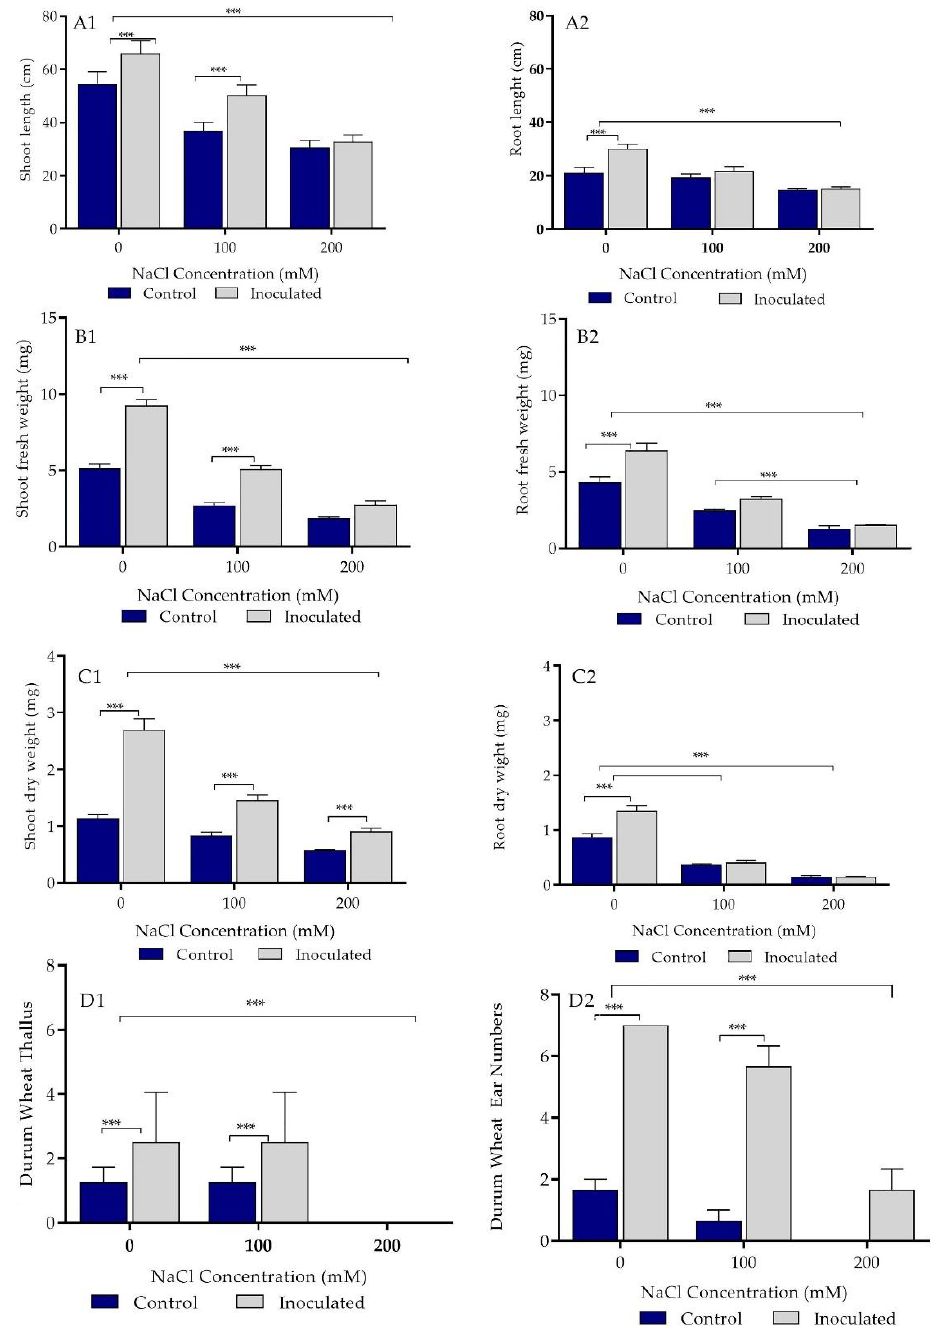
Figure 5. E ff ect of PGPR P. agglomerans strain Pa inoculation on growth parameters of durum wheat cv Waha grown in saline and non-saline settings in soil pots. ( A1 , A2 ) E ff ect of bacterial inoculation (strain Pa) on shoot and root length (cm) in the presence of three concentrations (0, 100, and 200 mM) of NaCl. ( B1 , B2 ) E ff ect of bacterial inoculation (strain Pa) on shoot and root fresh weight (mg) of Triticum durum L. cv Waha in the presence of three concentrations (0, 100, and 200 mM) of NaCl. ( C1 , C2 ) E ff ect of bacterial inoculation (isolate Pa) on shoot and root dry weight (mg) of T. durum L. cv Waha in the presence of three concentrations (0, 100, and 200 mM) of NaCl. ( D1 , D2 ) E ff ect of bacterial inoculation (strain Pa) on thallus and ear numbers of wheat plants grown in soil using three salt concentrations (0, 100, and 200 mM). Bar plots represent the mean ± standard error of three di ff erent experiments. We used GraphPad Prism 8 to make statistical analysis, using a two-way ANOVA setting followed by Tukey’s multiple comparison post-test. Only significant di ff erences are displayed: *** p <